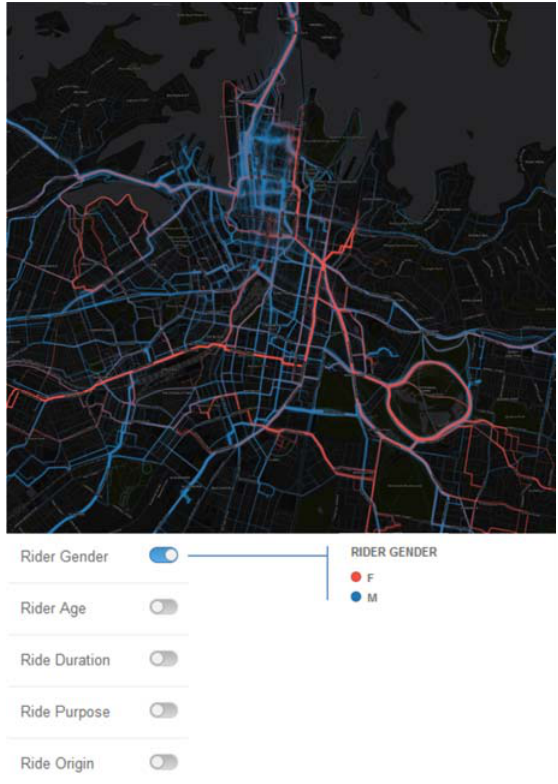
Figure 5. Sydney Area Rider Routes by